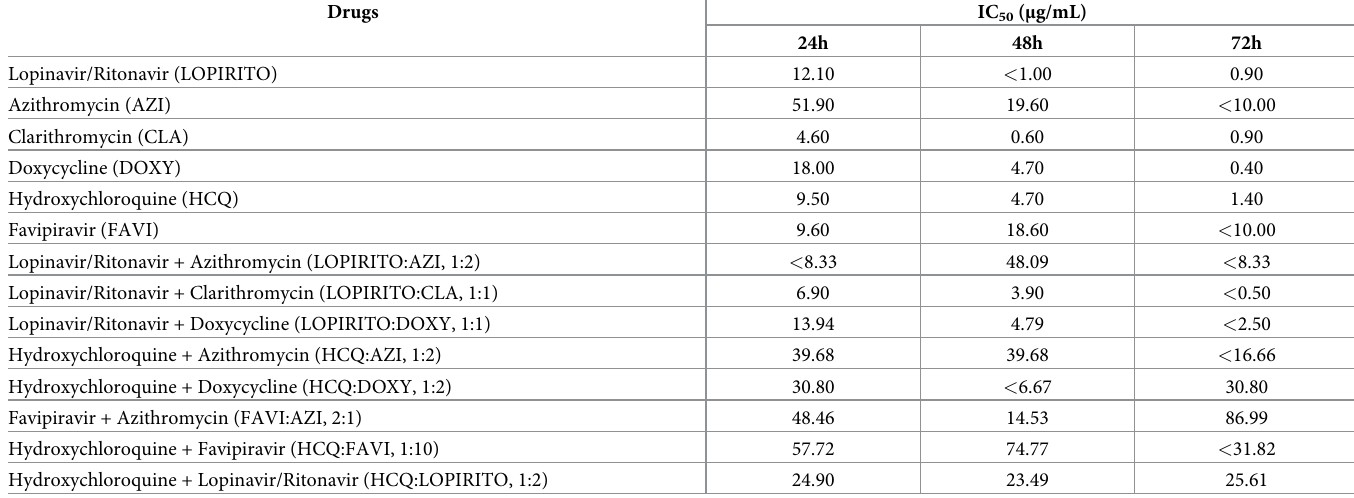
Table 3. The summary of antiviral activity (IC 50 ) of single and combination drugs against Vero cells infected with SARS-CoV-2 at an multiplicity of infection (MoI) value of 0.04.